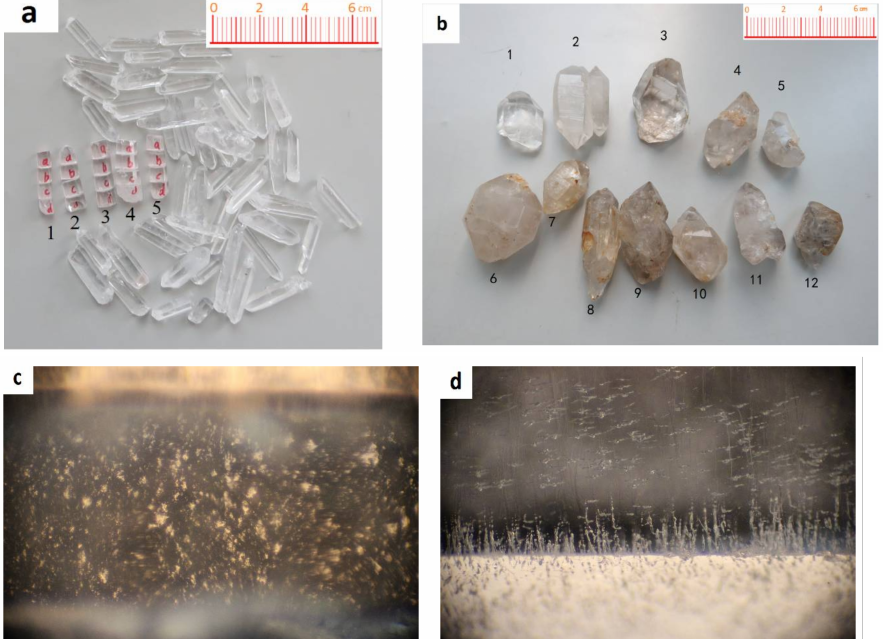
Figure 1. ( a ) Group I synthetic rock crystal samples; ( b ) Group II natural rock crystal rough samples;